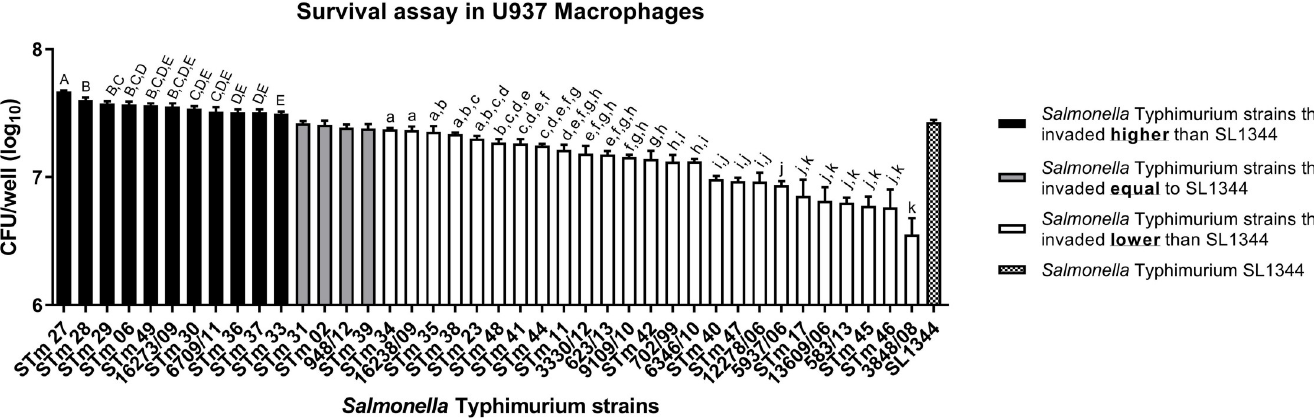
Fig 2. Survival assay in U937 human macrophages for the 40 S . Typhimurium strains isolated from humans and foods and for the S . Typhimurium SL1344 reference. The means followed by different letters differ statistically from each other at a level of 5% significance. The error bars represent standard deviation of biological